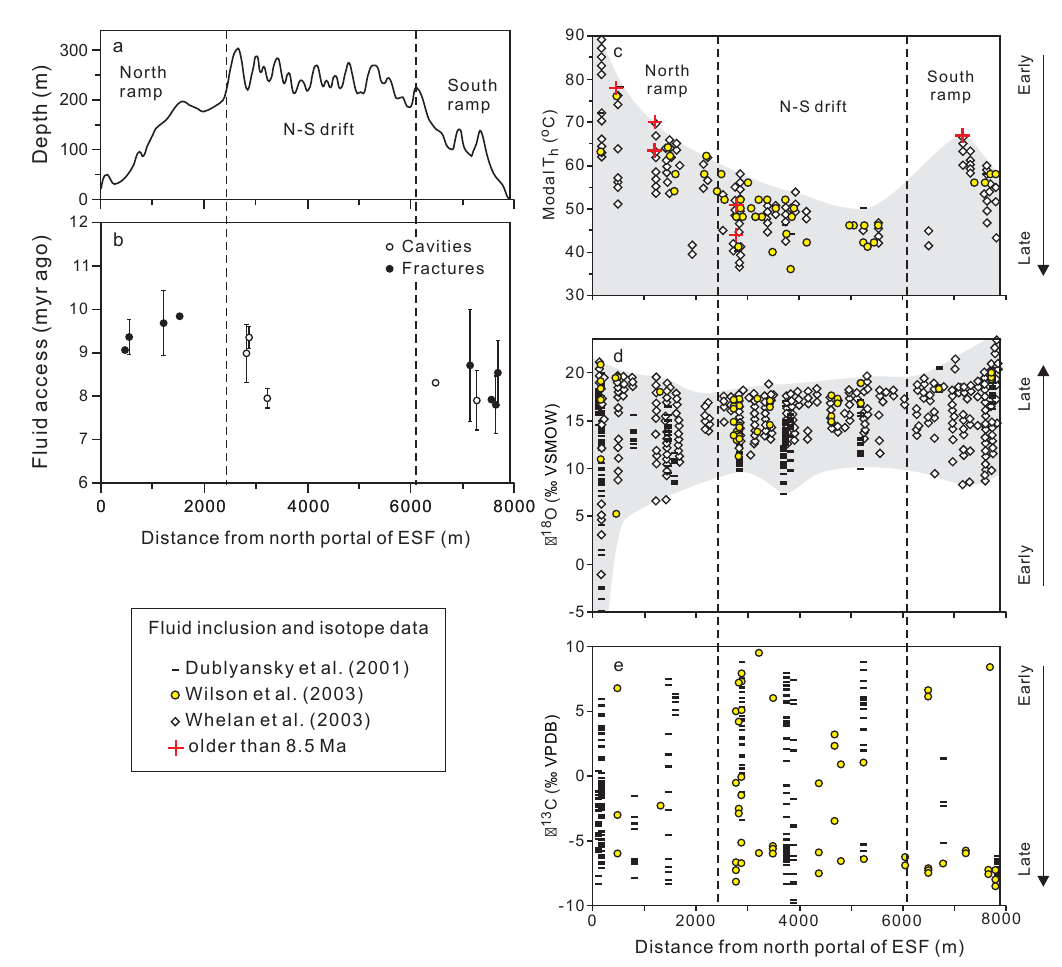
Figure B1. Characteristics of secondary calcite from the ESF tunnel: (a) depth from the topographic surface along the ESF; (b) oldest U–Pb age dates for different locations in the ESF; (c) maximum modal values of the homogenization temperatures; (d) δ 18 O properties; and (e) δ 13 C properties. U–Pb ages in (b) are from Neymark et al. (2002), Wilson et al. (2003), and Whelan et al. (2008). Red crosses in (c) indicate temperatures older than 8.5Ma (data from Wilson et al., 2003; Whelan et al., 2008). Each mode shown in (c) was calculated on the basis of tens to hundreds of individual measurements reported in Dublyansky et al. (2001), Wilson et al. (2003) and Whelan et al. (2003). Vertical dashed lines correspond to the bends in the ESF (cf. Fig.